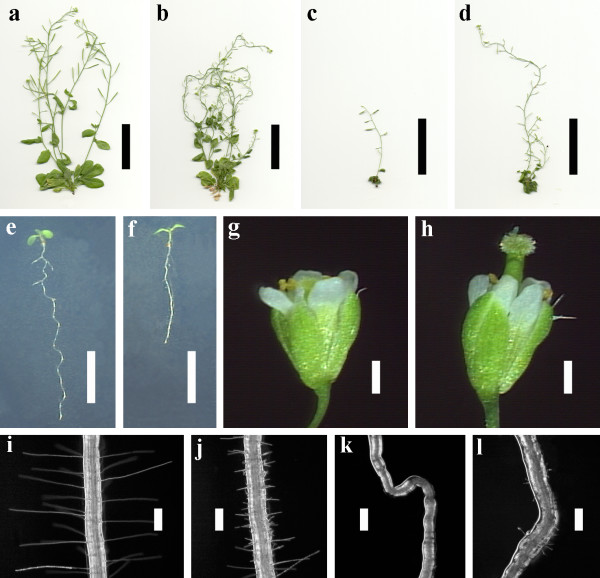
pax1-1 mutant phenotypes in wild-type and axr3 backgrounds. (a) Wild type, (b) pax1-1, (c) axr3-1 and (d) axr3-1 pax1-1 shoot morphology at maturity. Bar = 5 cm. (e) Wild type and (f) pax1-1 seedling 6 days after germination (dag). Bar = 1 cm. (g) Wild type and (h) pax1-1 flower. The elongated carpel phenotype seen in pax1-1 is also observed in axr3 pax1-1 double mutants. Bar = 0.5 mm. (i) Wild type, (j) pax1-1, (k) axr3-1 and (l) axr3-1 pax1-1 root hairs 3 dag. In pax1-1 and axr3-1 pax1-1, multiple roots hairs arise from a single root epidermal cell. Bar = 250 μm. All axr3-3 pax1-1 phenotypes were qualitatively similar to axr3-1 pax1-1, showing suppression of axr3 phenotypes by pax1-1.